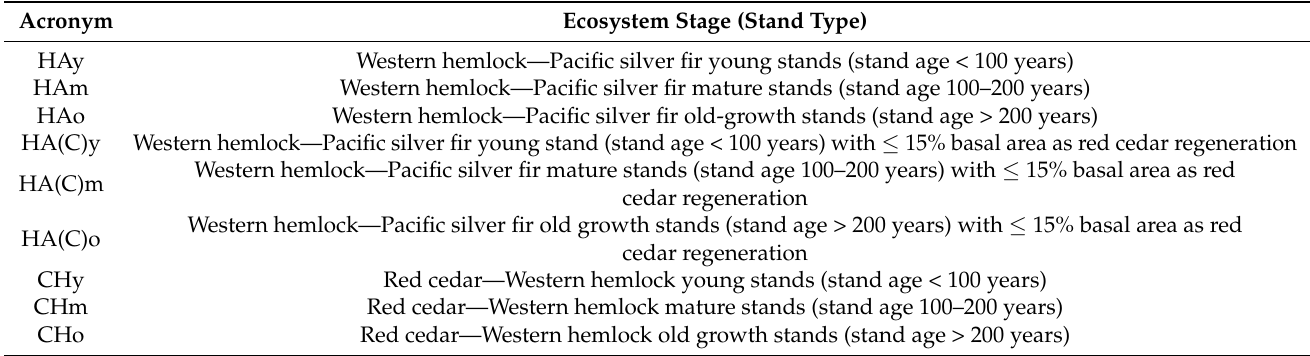
Table 1. Ecological stages (stand types by stand age) in which the forest can be in a given time. Acronym Ecosystem Stage (Stand Type)